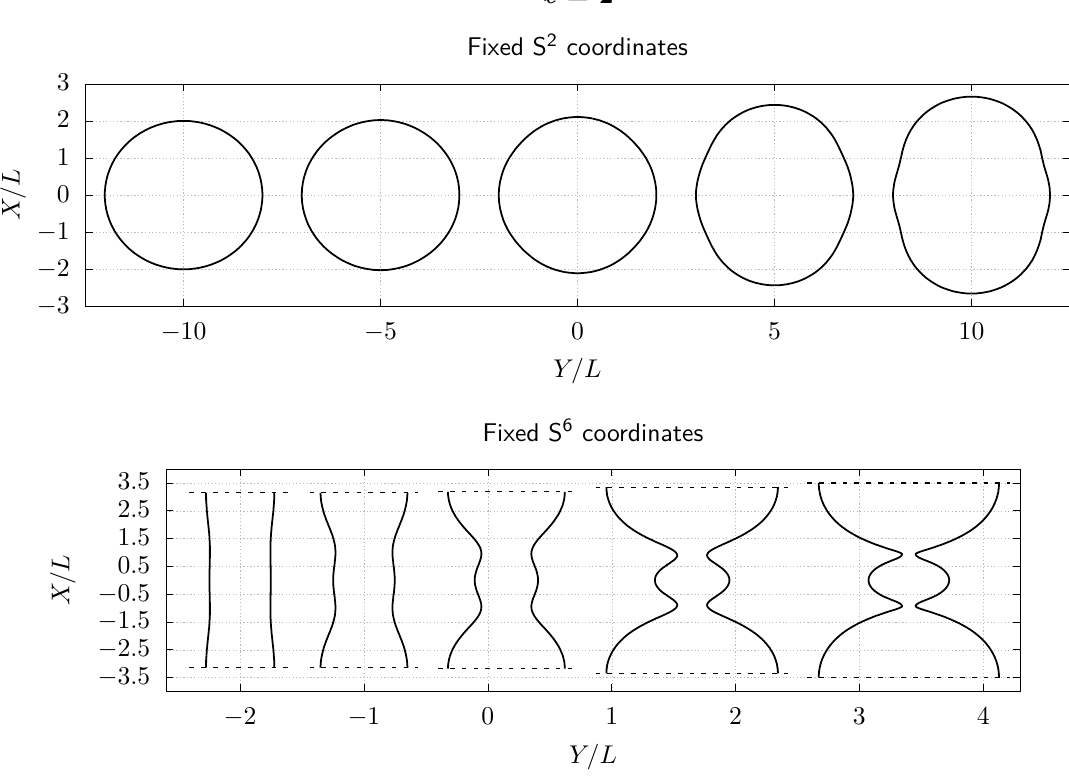
Figure 13. Embedding plots for fixed S 2 /S 6 coordinates of lumpy black holes in AdS 4 × S 7 with ‘ = 2 − . This family merges with a black hole whose horizon topology is the connected sum S 9 #( S 3 × S 6 )# S 9